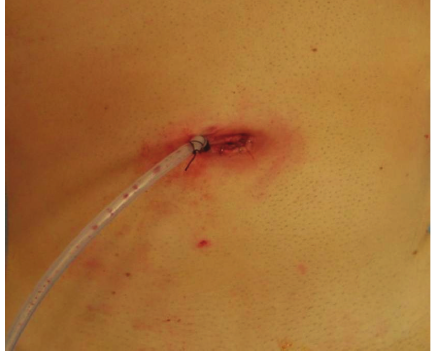
Figure 4: Drain through a periumbilical